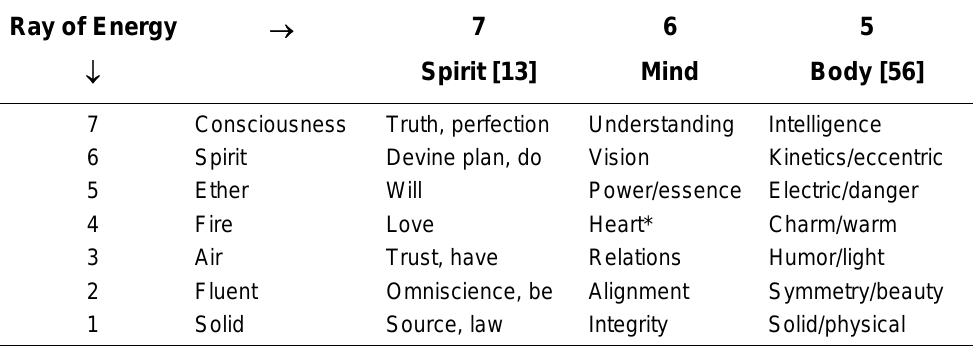
The Major Spiritual, Mental, and Physical